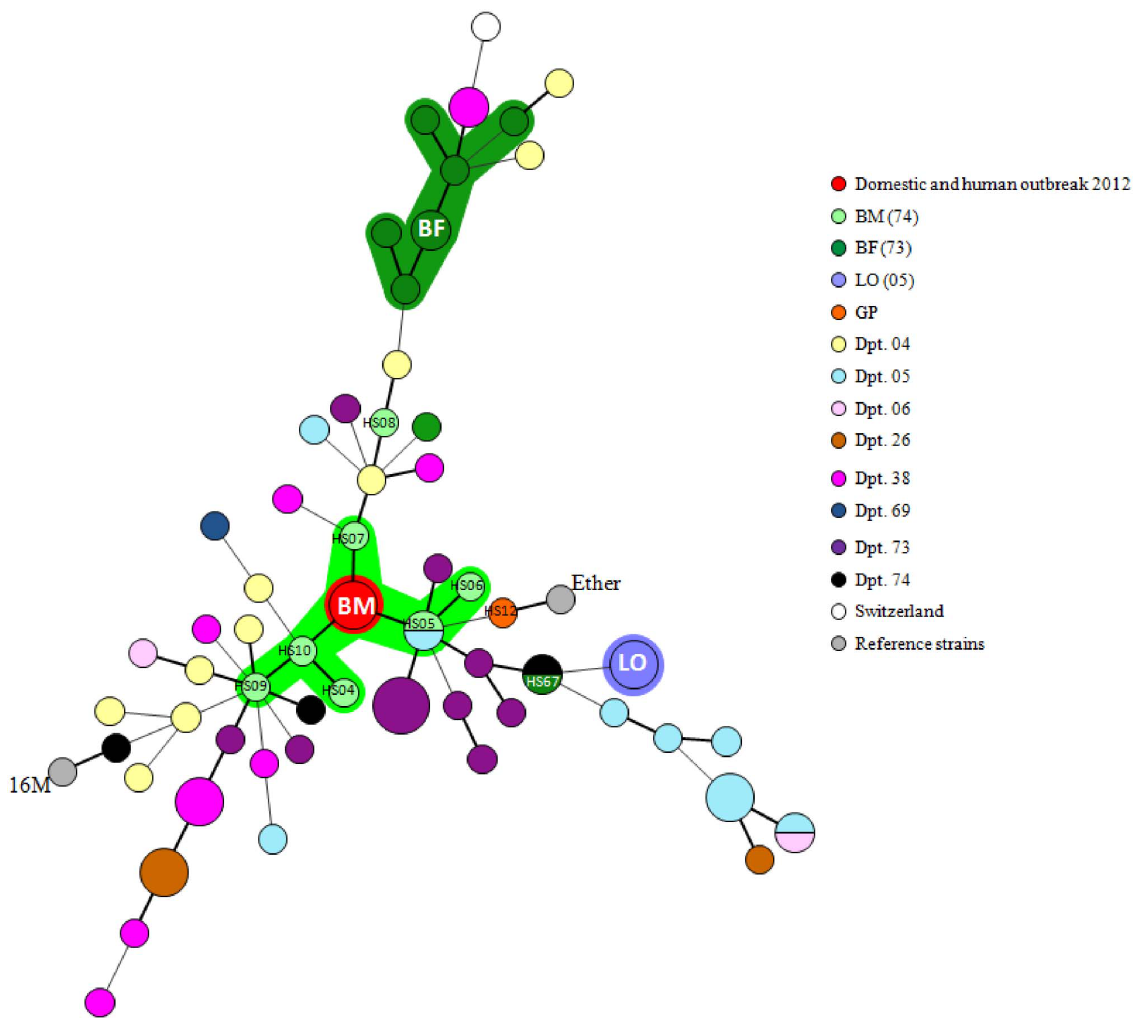
Figure 3. MST of clustered MLVA-panel2B genotypes. The MST was constructed with a categorical coefficient (with 1/HGDI weight for each locus). Size of circles reflects the number of isolates with a particular MLVA genotype. Width of the line reflects the genetic distance between the genotypes (heavy short lines connect single locus variants SLV, thin longer lines connect double locus variants DLV). Red circle, called BM for Bargy Massif, represents isolates from the recent domestic and human outbreak 2012. The strain codes are specified for recent cases (HS04-HS10) and other cited strains in results/discussion ( e.g . HS67). Each department/country is assigned a different color, as well as the outbreak areas. BM: Bargy Massif ( i.e. the isolates from wildlife investigation campaign of 2012); BF: Beaufortain outbreak (1996–2001); LO: Lautaret outbreak (1982–1993); GP: Gran Paradiso outbreak (1990s). (Table S1).